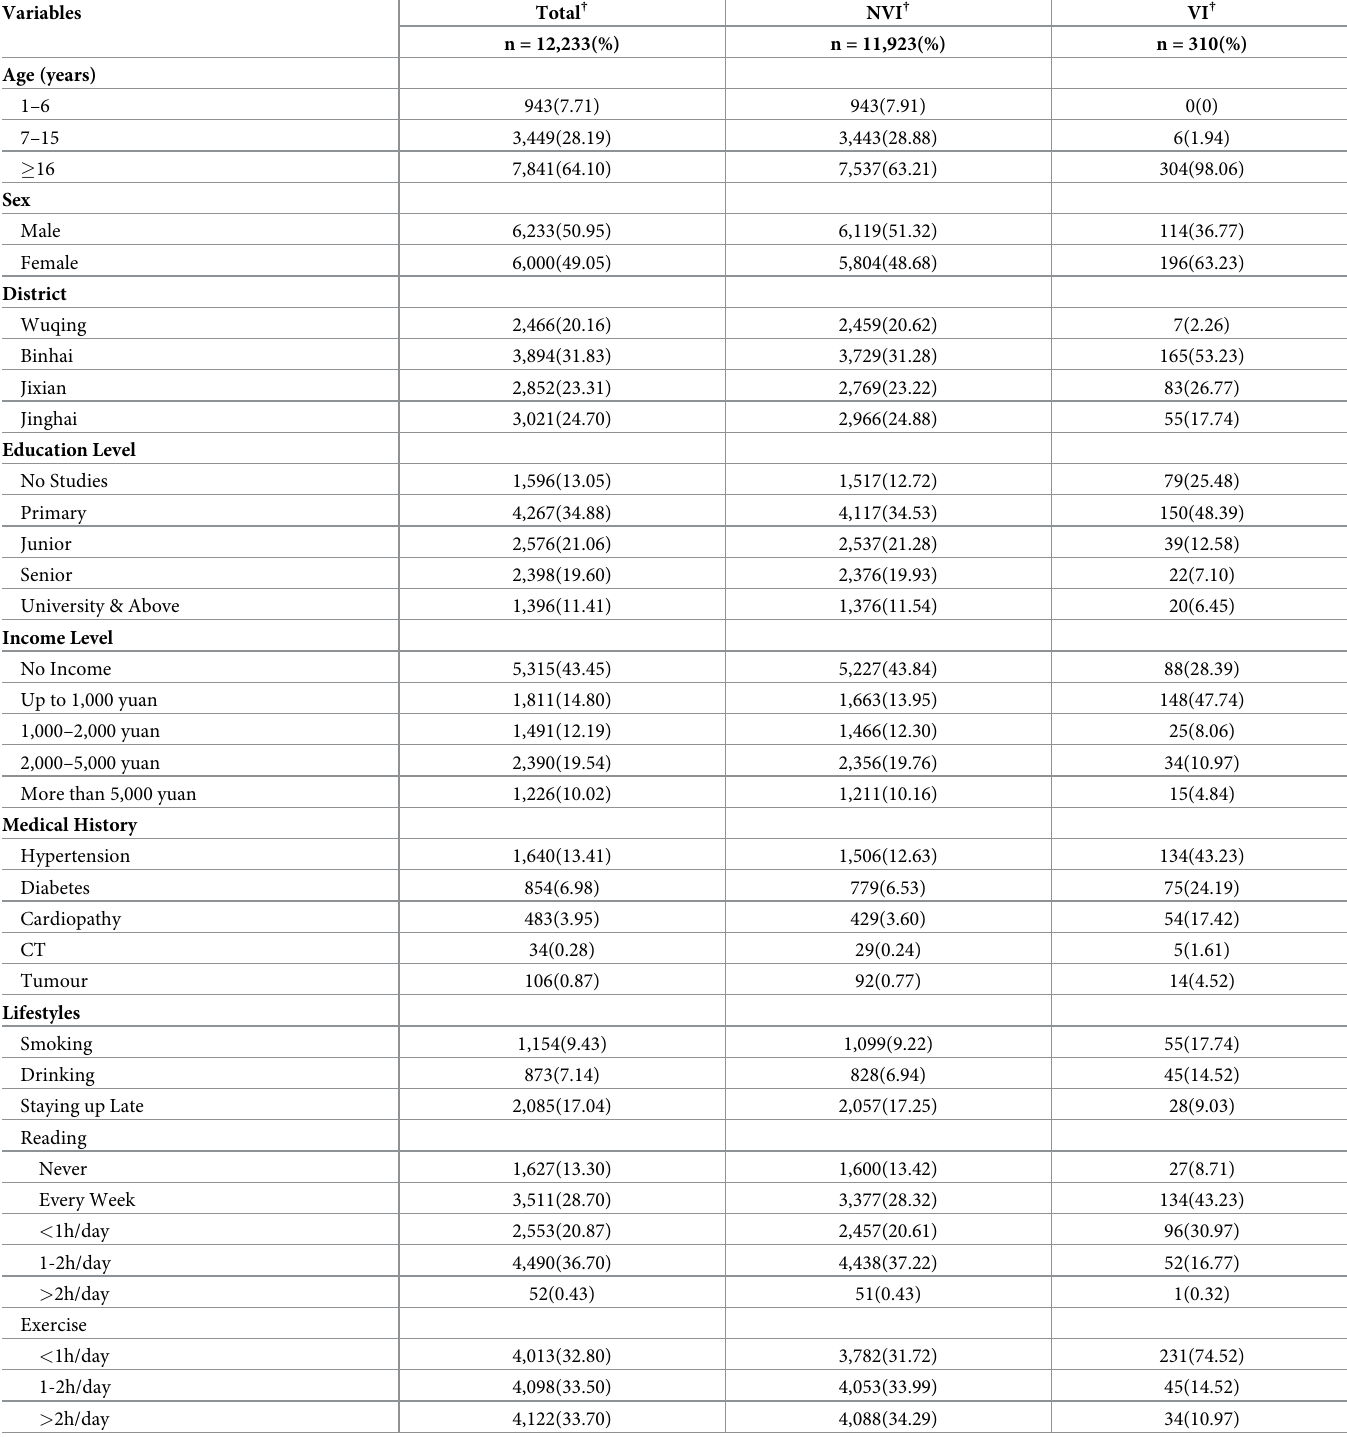
Table 2. Distribution of demographic, socio-economic status, medical history and lifestyle variables among all participants and people with or without visual